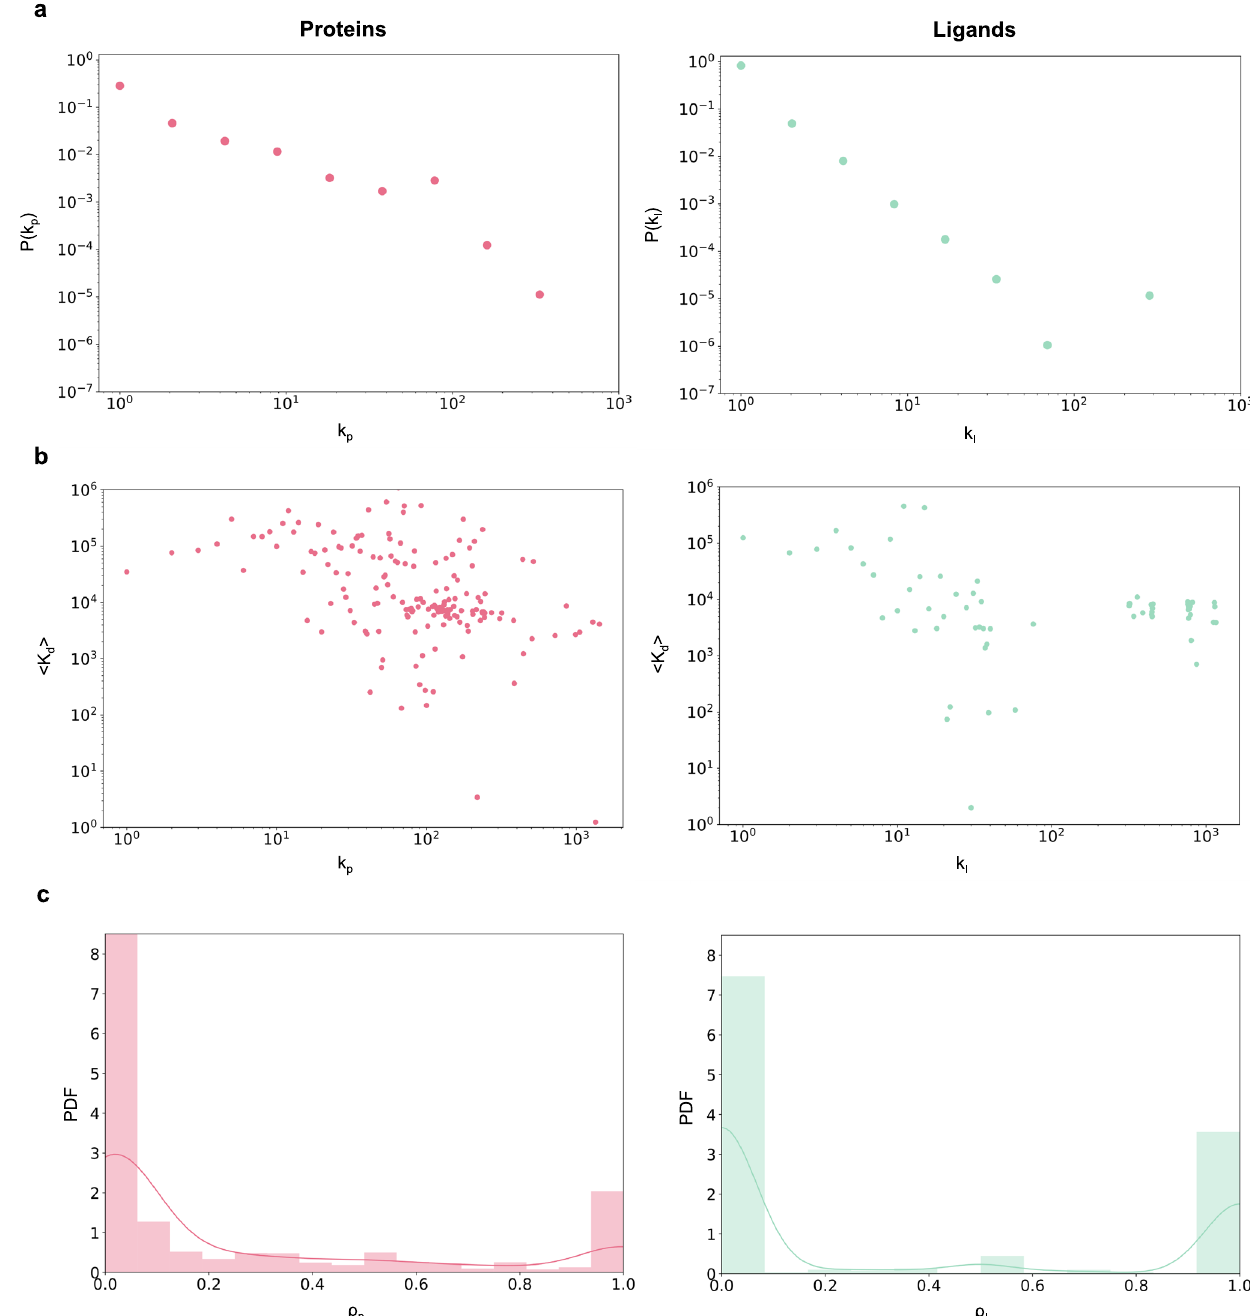
Fig. 1 | Annotation bias in BindingDB training data and DeepPurpose predictions. a Distributions of the number of annotations in the benchmark Bin- dingDBdataareshownindoublelogarithmicaxes(log-logplot),indicatethat P ( k p ) and P ( k l )arewellapproximatedbyapowerlawforbothproteins(pink)andligands (green), with approximate degree exponents γ p =2.84 and γ l =2.94, respectively. b The average K d over the links for different degree values { k p } are negatively correlated with r Spearman ( k p , 〈 K d 〉 )= − 0.47. For the ligands, we observe similar anti- correlation with r Spearman ( k l , 〈 K d 〉 )= − 0.29. c The distribution of degree ratios for the proteins { ρ p } and the ligands { ρ l } in the original DeepPurpose training dataset (for a selected fold from the 5-fold cross-validation). The degree ratio, de fi ned